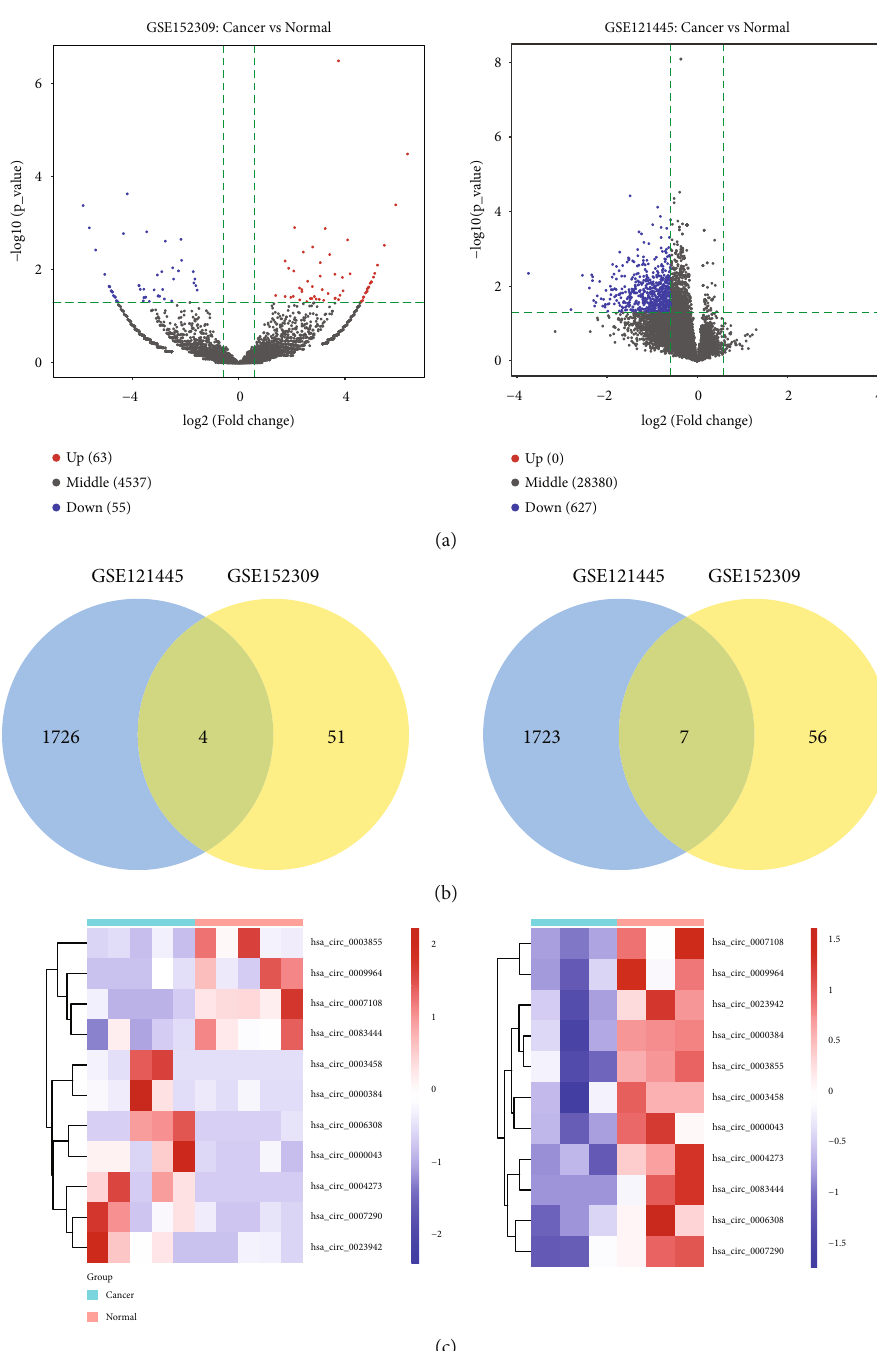
Figure 1: Identi fi cation of DEcircRNAs between GC and adjacent tumor-free gastric tissue samples by di ff erentially analyzing the raw data of the GSE152309 (5 paired tumor and nontumor tissues) and GSE121445 (3 paired tumor and nontumor tissues) datasets. (a) The volcano plots. (b) Venn diagram showing 11 overlapped DEcircRNAs in two datasets. (c) The heatmaps showing expression diversity of 11 overlapped DEcircRNAs in two datasets, among which color more red indicates higher expression and more blue indicates lower